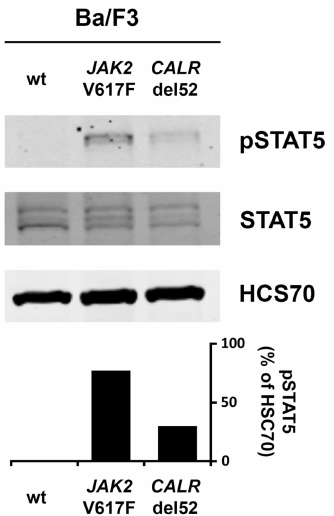
Figure A3. Wild type (wt) Ba / F3 cells or Ba / F3 cells transfected with either JAK2 V617F or CALRdel52 were incubated overnight in medium without IL-3. After, cell lysates were subjected to Western blotting using antibodies against pSTAT5, STAT5 and HSC70. The columns show the levels of pSTAT5 in percent of HSC70 as analyzed by densitometry. Uncropped blots are shown in Figure